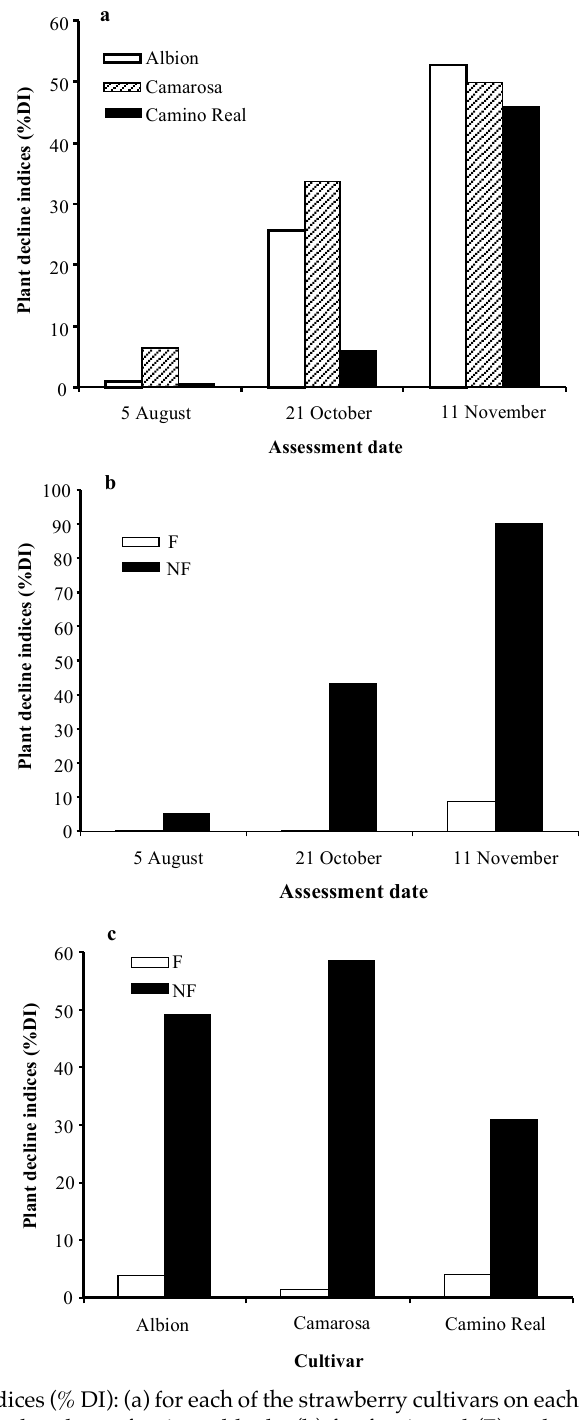
Figure 1. Mean plant decline indices (% DI): (a) for each of the strawberry cultivars on each assessment date taken as means of the % DI across the fumigated and non-fumigated beds; (b) for fumigated (F) and non-fumigated (NF) field beds on each assessment date taken as means of the % DI across the three cultivars; and (c) for fumigated (F) and non-fumigated (NF) field beds for each of the cultivars taken as means of the % DI across the three assessment dates; field experiments at Wanneroo, Western